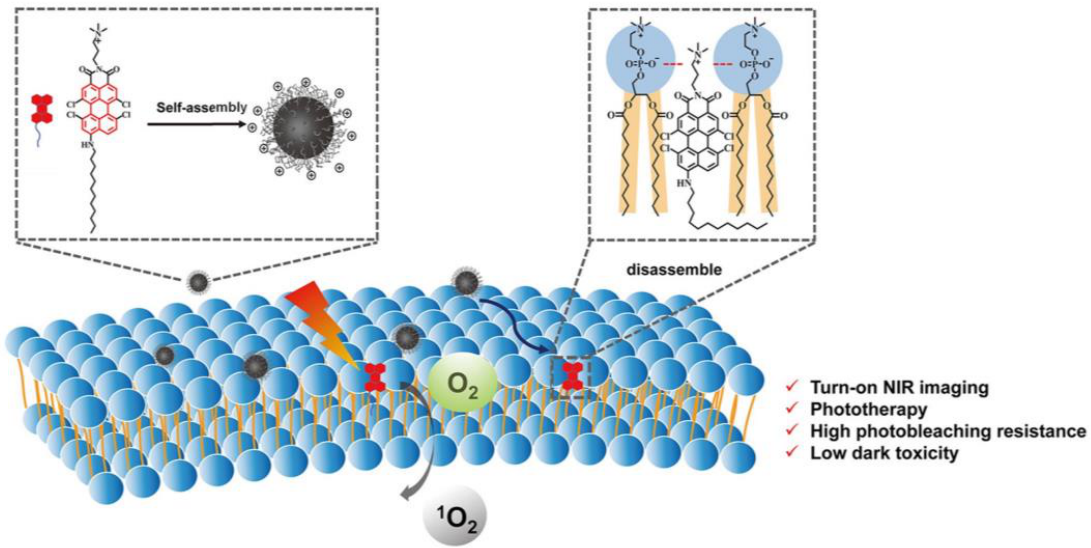
Figure 4. Schematic illustration of AP-based turn-on NIR fluorescence imaging and PDT. Reprinted with permission from Ref. [44]. Copyright 2021 American Chemical Society.